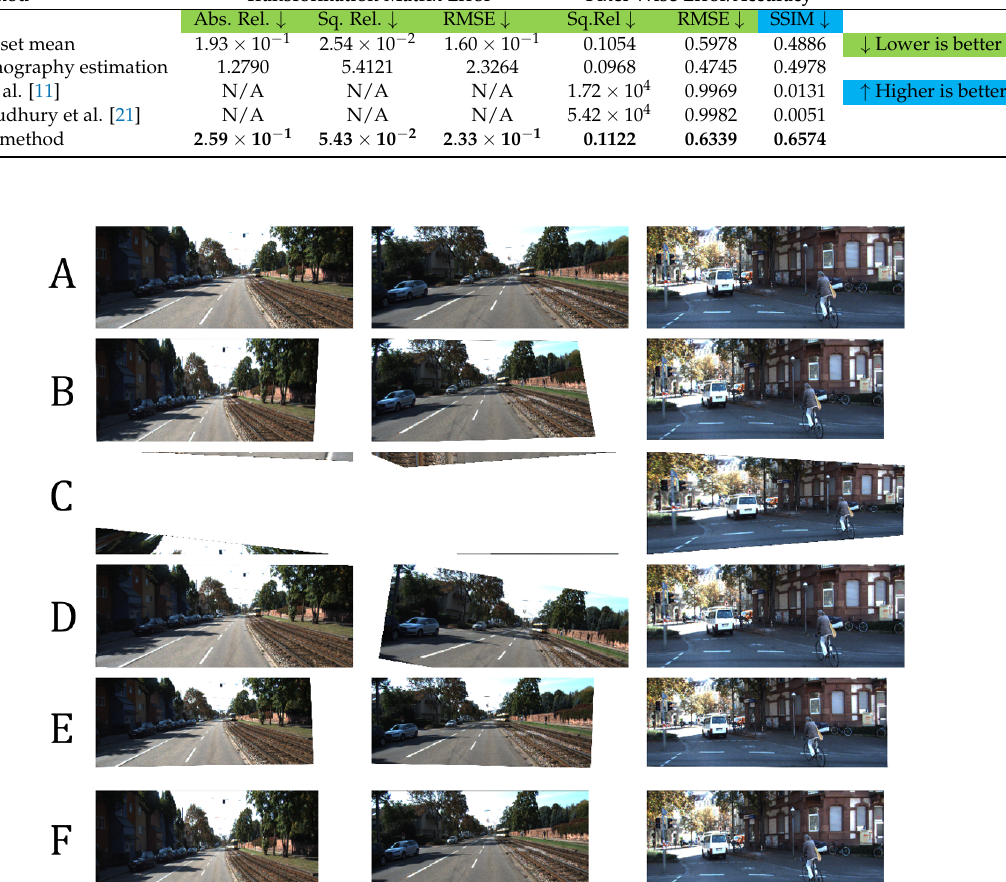
Figure 11. Corrected images with scaling distortion. ( A ): Distorted input images. ( B ): Corrected image using homography estimation ( C ): Corrected image using the technique of Chaudhury et al. [21]. ( D ): Corrected image using the technique of Li et al. [11]. ( E ): Corrected image using our method. ( F ): Ground-truth. Our network can resize the image back to their original